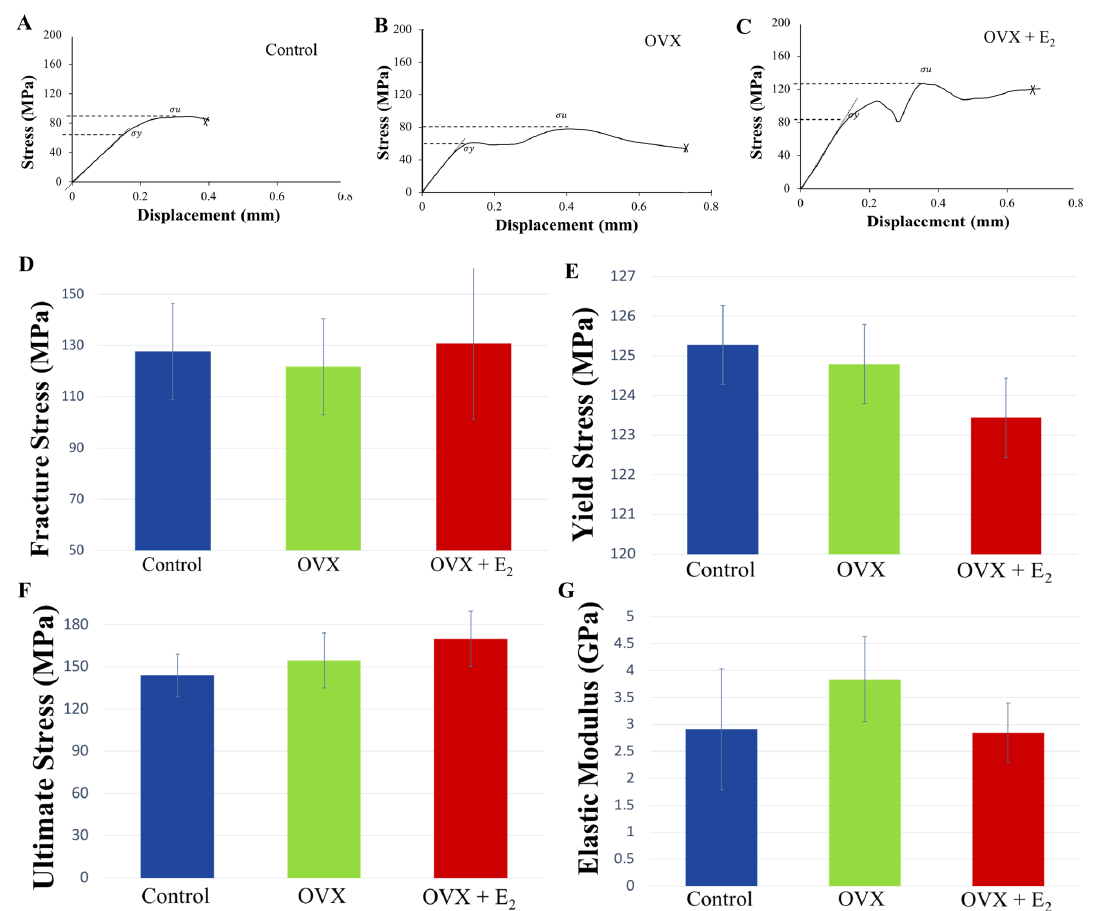
Figure 4. Representative stress-displacement deformation plots for tibiae in the ( A ) control, ( B ) OVX, and ( C ) OVX + E 2 groups. “Pop-in” events were present, and were attributed to either the progression of existing microcracks present within the bone structure or the initiation of new microcracks, which ultimately culminated in whole bone fracture. The mechanical properties of ( D ) fracture strength σ f , ( E ) yield stress σ y , ( F ) ultimate stress σ u , and ( G ) elastic modulus E , at the tibial mid-point in the control, OVX, and OVX +E 2 groups ( n = 6). Means ± SE are presented in Supplementary Table S3.